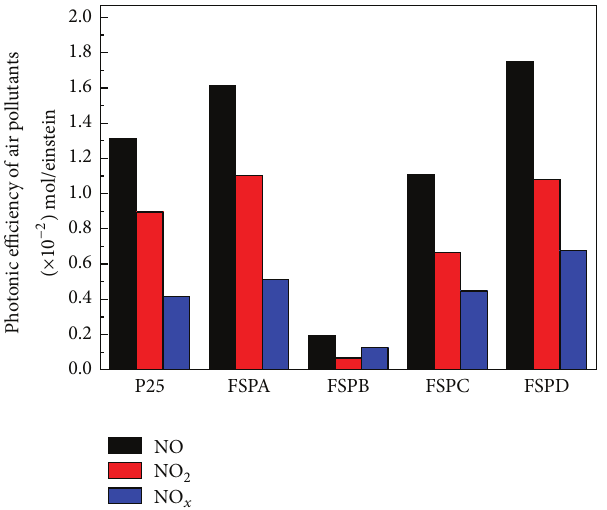
Figure 7: Photonic efficiencies in NO oxidation, NO 2 formation, and overall NO 𝑥 removal of the TiO 2 /perlite